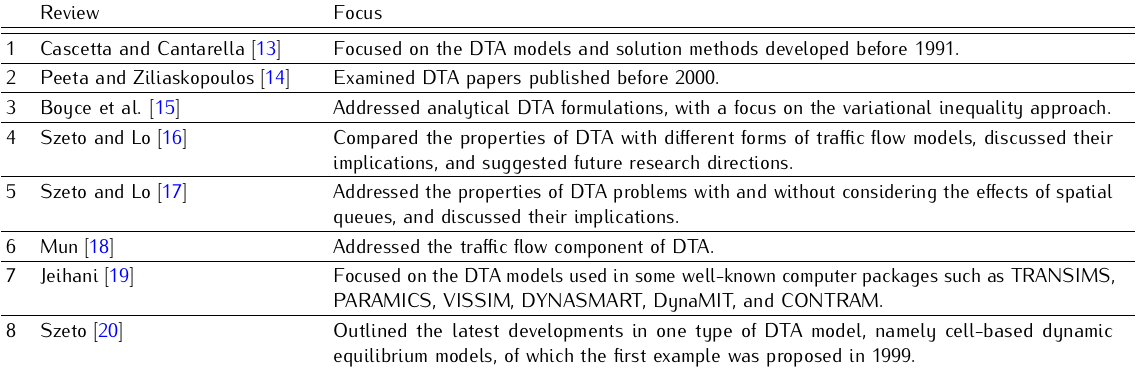
Table 3. Recent comprehensive DTA reviews and their